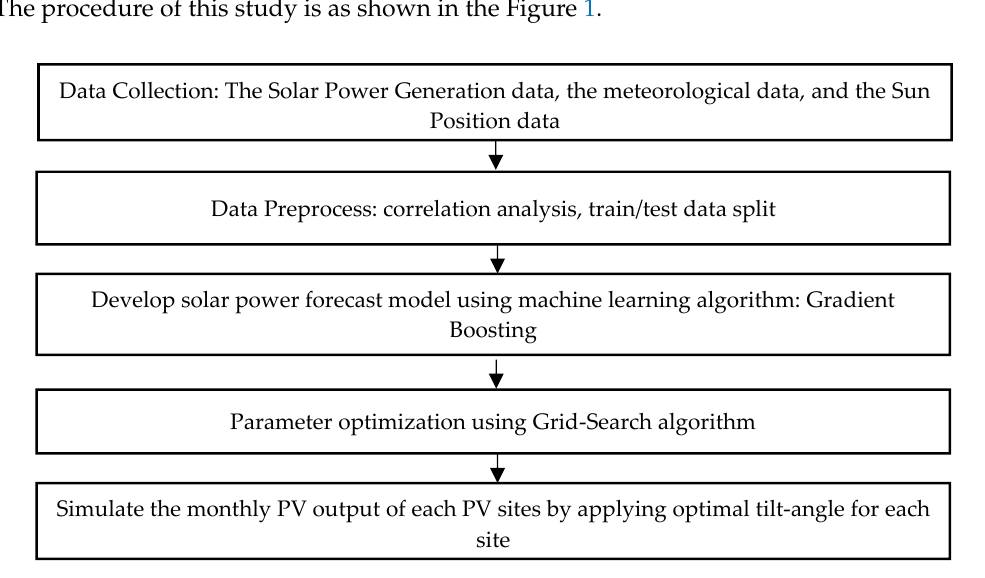
Figure 1. Procedure of the proposed methodology.